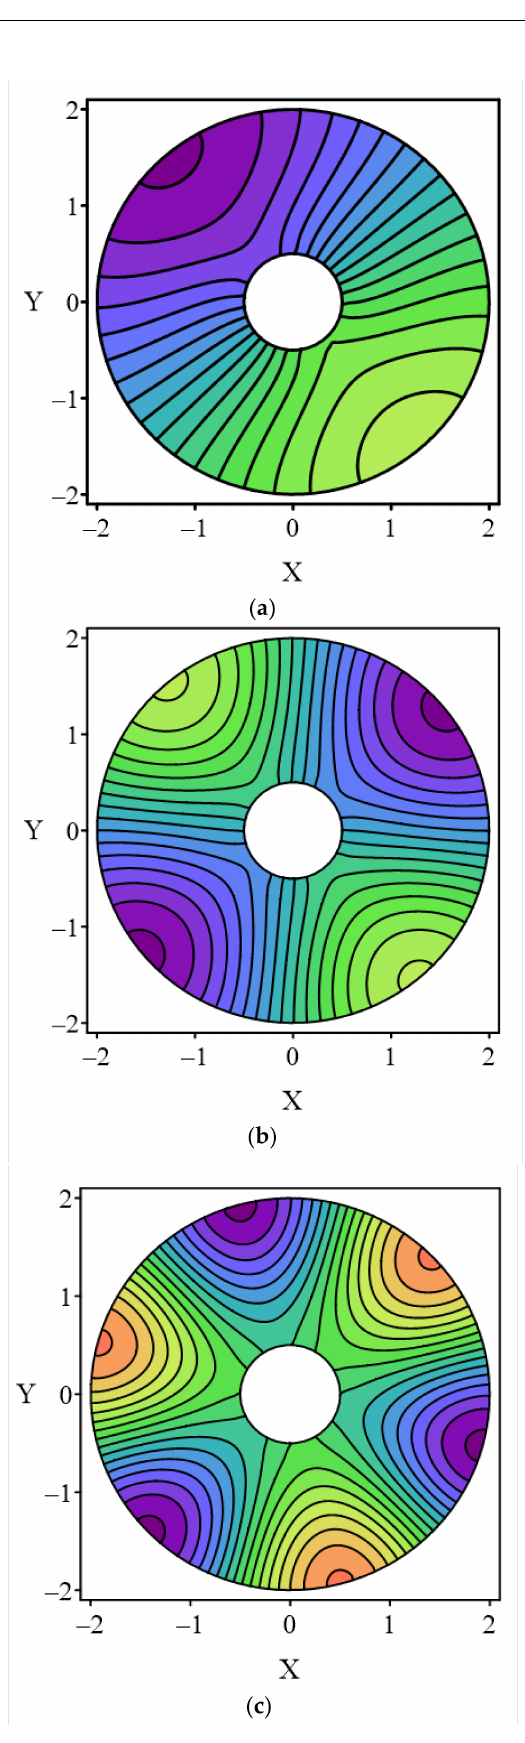
Figure 8. The first three eigenmodes for concentric annular waveguide (TE wave): ( a ) k 1 = 0.8222, ( b ) k 2 = 1.5045, and ( c ) k 3 =